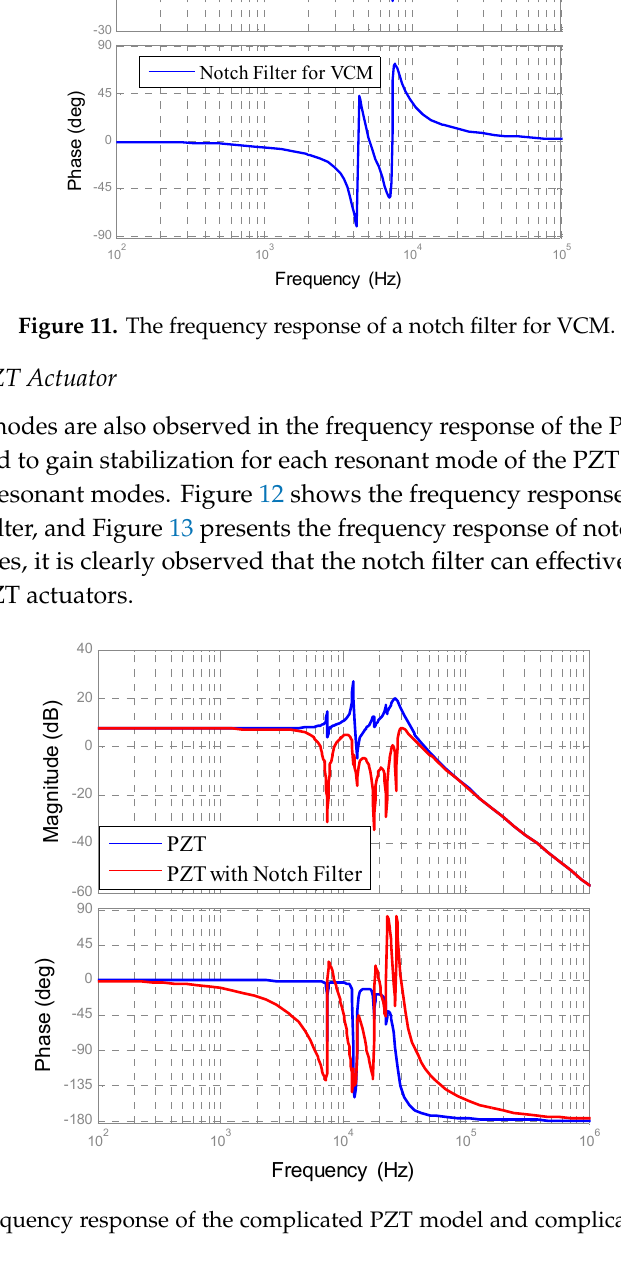
Figure 10. The frequency response of the VCM model, and the VCM model with a notch filter .